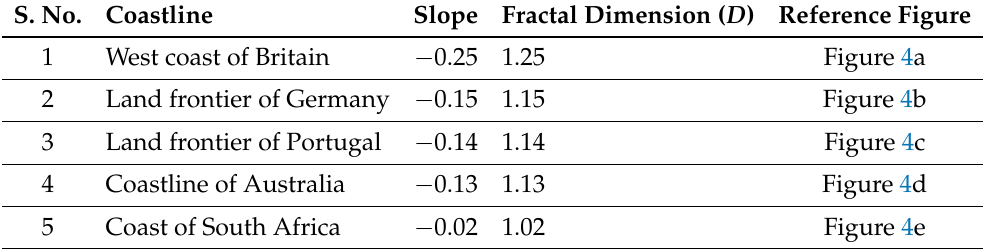
Table 2. Slopes obtained by Richardson (1961) and fractal dimension ( D ) calculated by Mandelbrot (1967).